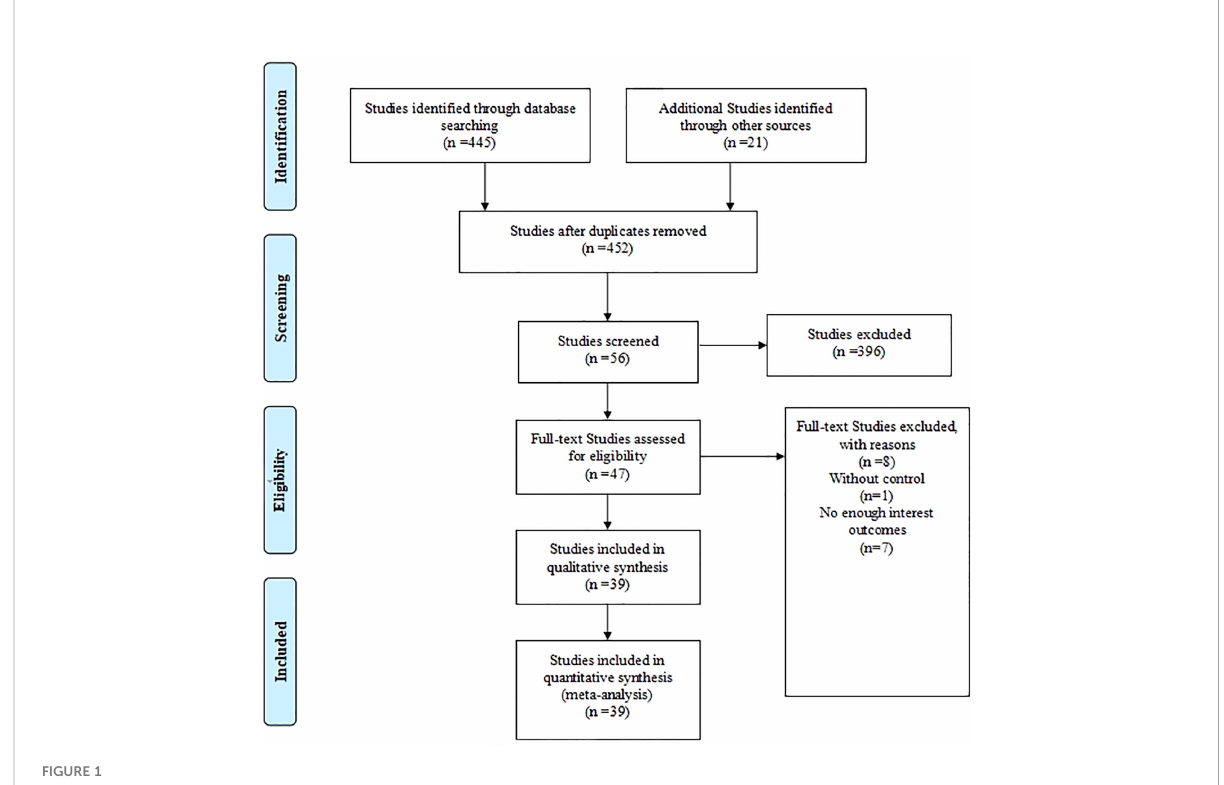
FIGURE 1 PRISMA fl ow